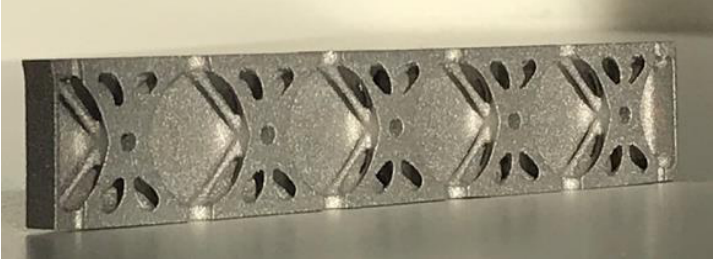
Figure 15. As-printed image of the sectioned Edge insert.